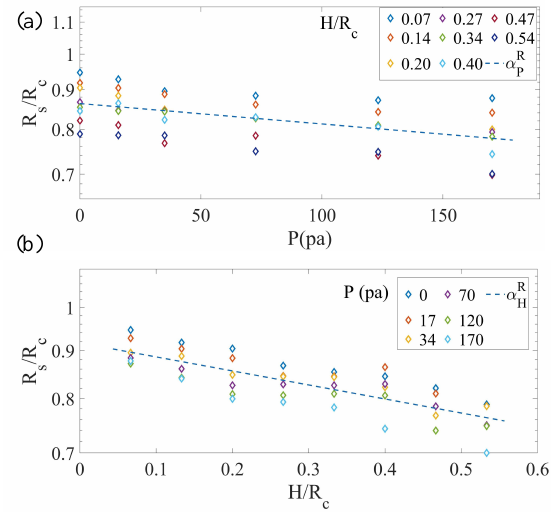
Figure 4. Position of the shear band, R s / R c , in terms of (a) P for increasing values of the filling height H / R c from 0 . 07 to 0 . 54 (the dashed lines shows α R , the exponential decay of the average P R s / R c for increasing P ) and (b) H / R c for increasing values of the external pressure P from 0 to 170 pa (the dashed lines shows α R , H the exponential decay of the average R s / R c for increasing H